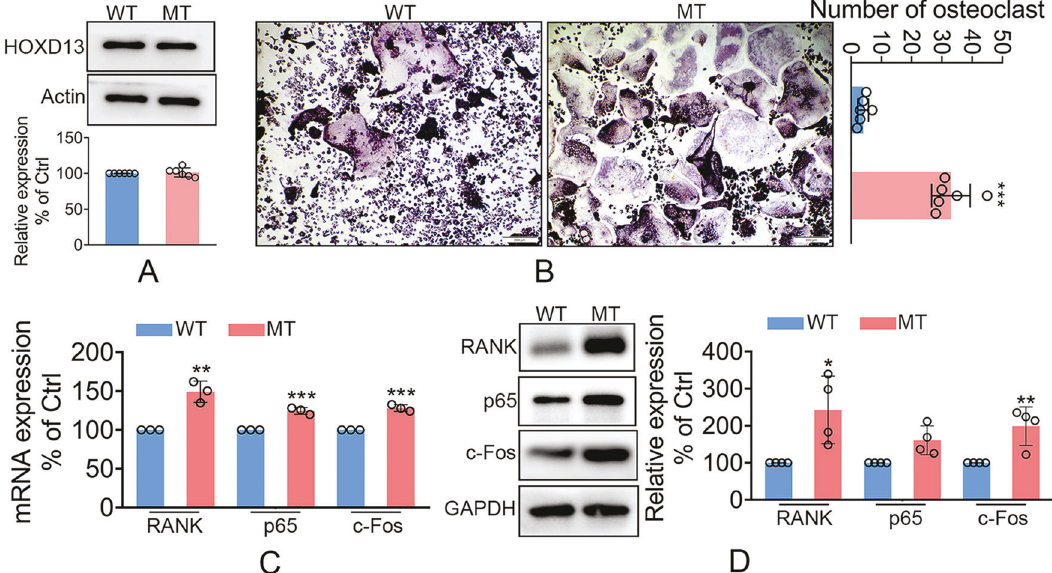
Fig. 3 The Hoxd13 mutation promoted the osteoclast differentiation. A The effect of Hoxd13 mutation on the expression of HOXD13 protein. B The effect of Hoxd13 mutation on osteoclast differentiation analyzed using TRAP staining. *** p < 0.001. C The effect of Hoxd13 mutation on the mRNA expression of osteoclast-associated genes. ** p < 0.01; *** p < 0.001. D The effect of Hoxd13 mutation on the expression of osteoclast-associated proteins. * p < 0.05; ** p < 0.01. All experiments were repeated at least three